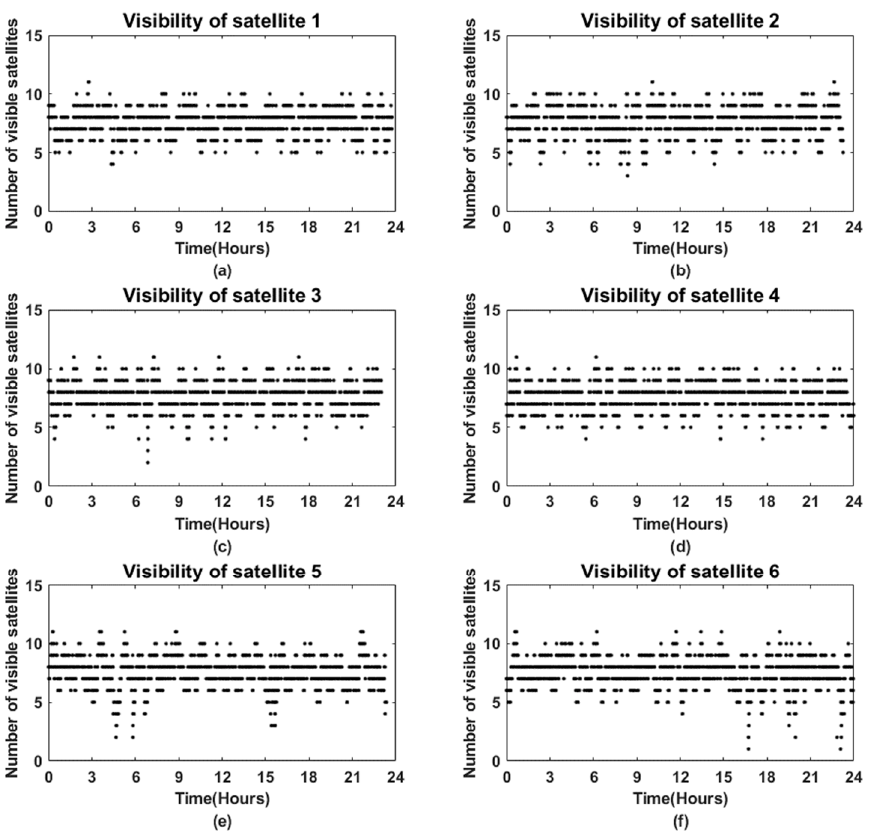
Figure 2. Numbers of visible GPS satellites of six COSMIC-2 satellites, DOY 138, 2021 (( a – f ) are visibility of satellite 1~6 respectively). Table 1. Percentage statistics of the visible number of GPS satellites for the six COSMIC-2 satellites, DOY 138-142, 2021.